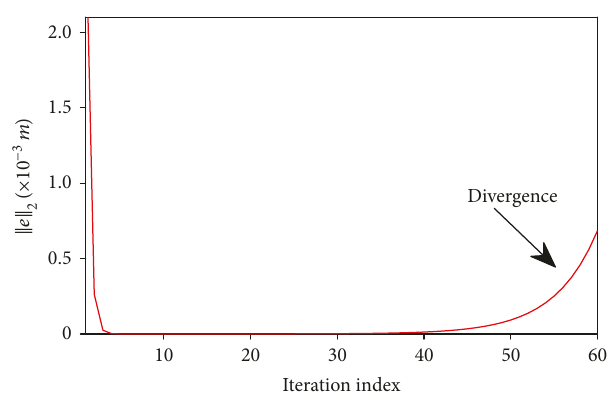
Figure 1: The phenomenon of initial convergence followed by divergence in ILC with only a learning fi